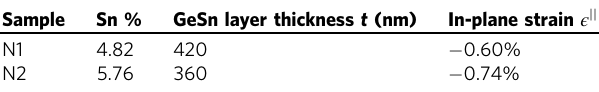
Table 1 Characterization results obtained for the epitaxially grown